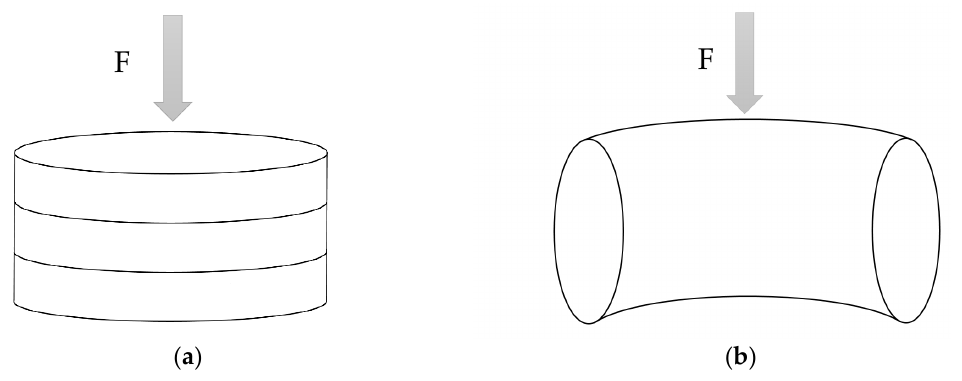
Figure 1. Schematic representation: ( a ) Stacked disks with axial loading; ( b ) O-ring segment with radial